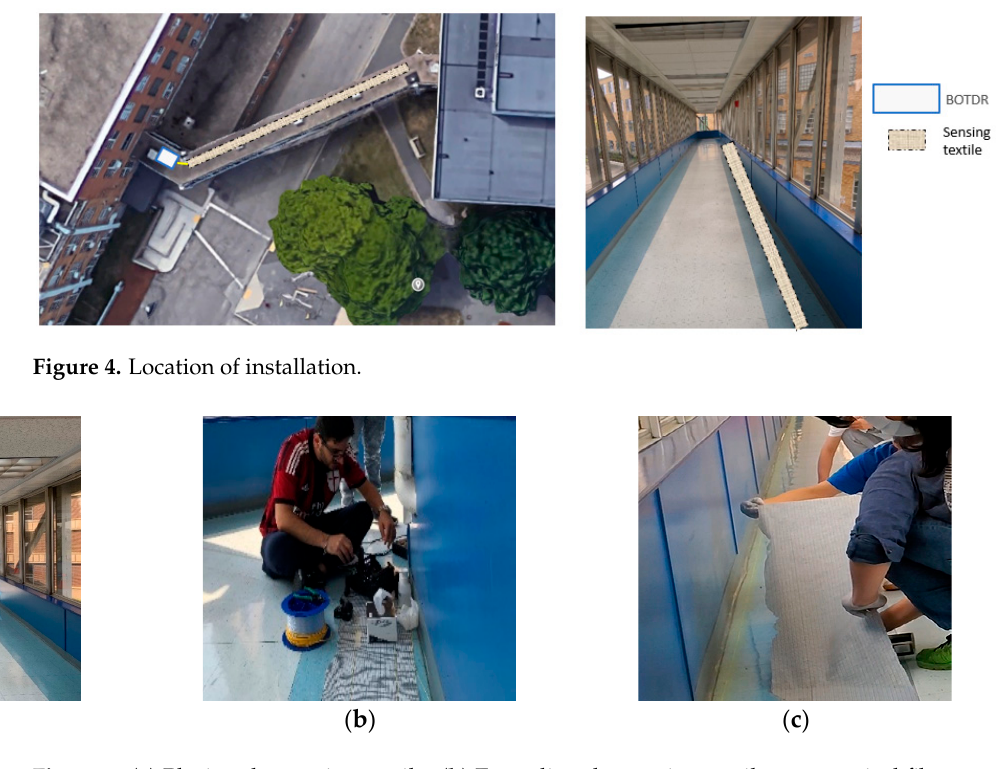
Figure 5 . ( a ) Placing the sensing textile. ( b ) Extending the sensing textile to an optical fiber spool. ( c ) Applying 3M Hi-Strength 90 spray adhesive between the floor and the sensing textile.